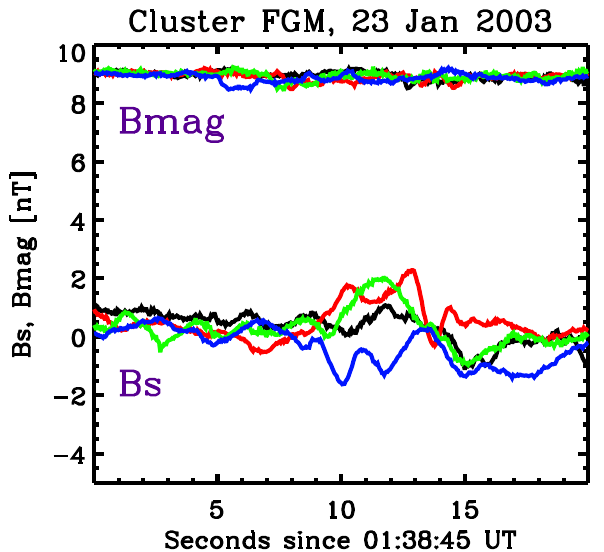
Fig. 6. Magnetic field magnitude and normal component for the Cluster discontinuity crossing on 23 January 2003, 01:38:45UTC to 01:38:55UTC (S/C 1: black, S/C 2: red, S/C 3: green, S/C 4: blue).